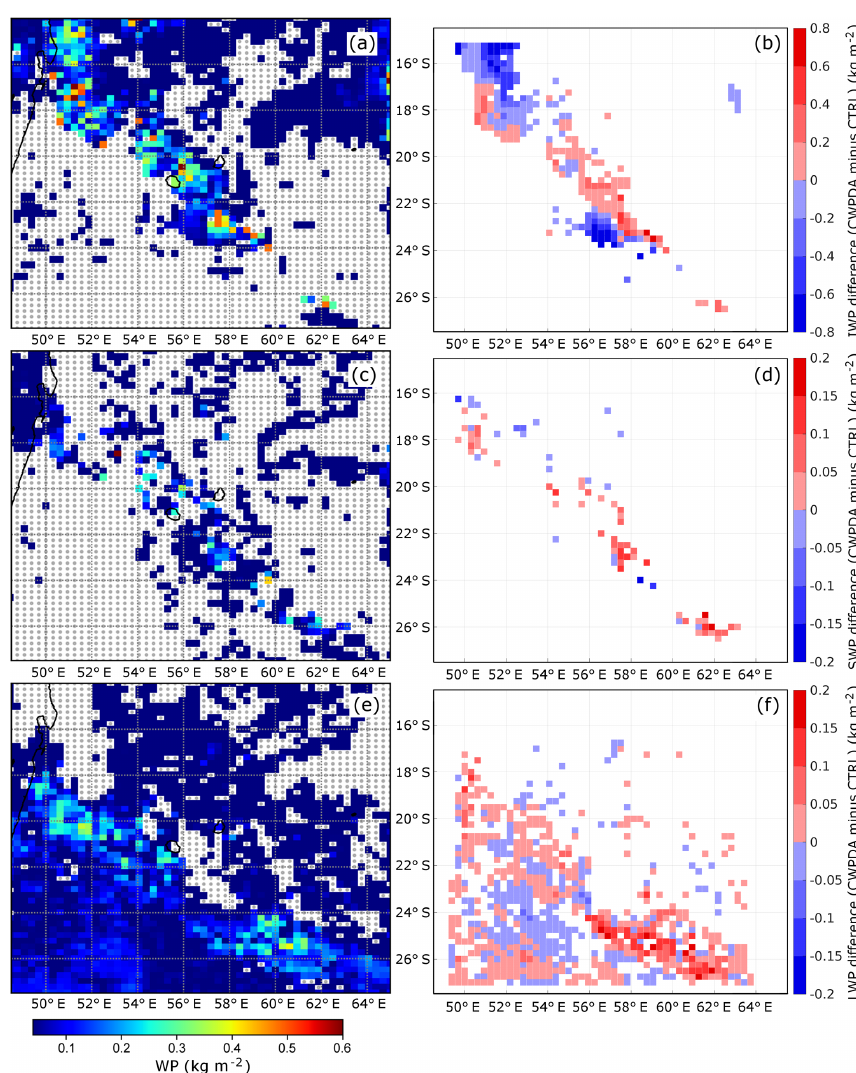
Figure 6. Maps of SatCORPS Meteosat-8 gridded CWP retrievals for the three phases IWP (a) , SWP (c) , and LWP (e) , and the difference of the posterior ensemble mean between the two cycling experiments (CWPDA minus CTRL) for the three phases, i.e. IWP diff (b) , SWP diff (d) , and LWP diff (f) . Missing observations are shown in grey. Red indicates that CWPDA generates higher WP values than CTRL, and blue indicates that CWPDA generates lower values than CTRL. Only locations where the retrievals were successfully assimilated in CWPDA are shown in the plots. All plots show 12 January 2018,